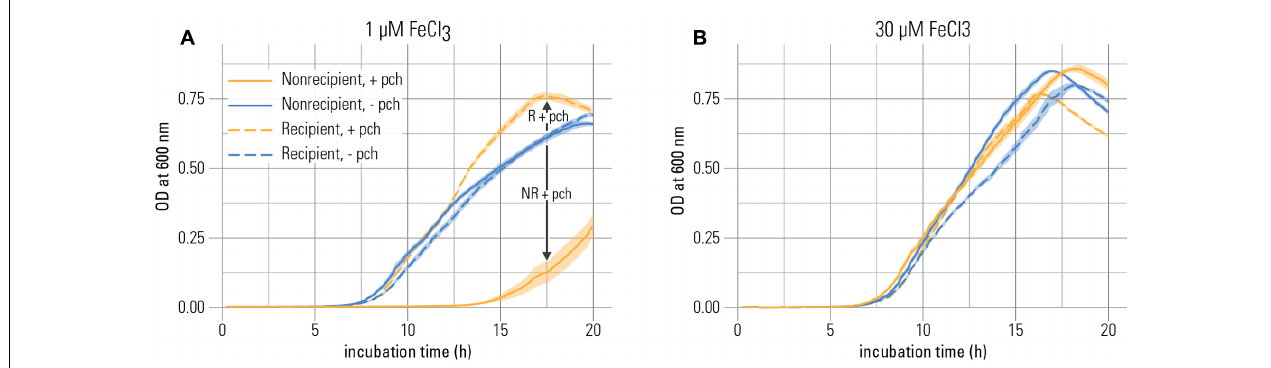
FIGURE 1 | Pyochelin inhibits growth of a strain without pyochelin receptor at iron limitation. (A) At low iron concentration (1 µ M), growth of the non-recipient strain NR (without pyochelin receptor) is inhibited upon addition of 6 µ M pyochelin (+ pch; compare the blue solid line to the orange solid line). Growth of a recipient strain R with a functional pyochelin receptor is not inhibited upon addition of pyochelin (compare blue dashed line to orange dashed line). (B) At higher iron concentrations (30 µ M), the inhibitory effect of pyochelin addition on the non-recipient is strongly reduced (compare the blue solid line to the orange solid line). Data represents mean optical density (O.D.) measurements of nine replicates; the standard error of the mean is indicated as shaded areas around the lines. The growth parameters extracted from these growth curves are depicted in Supplementary Figure S1.